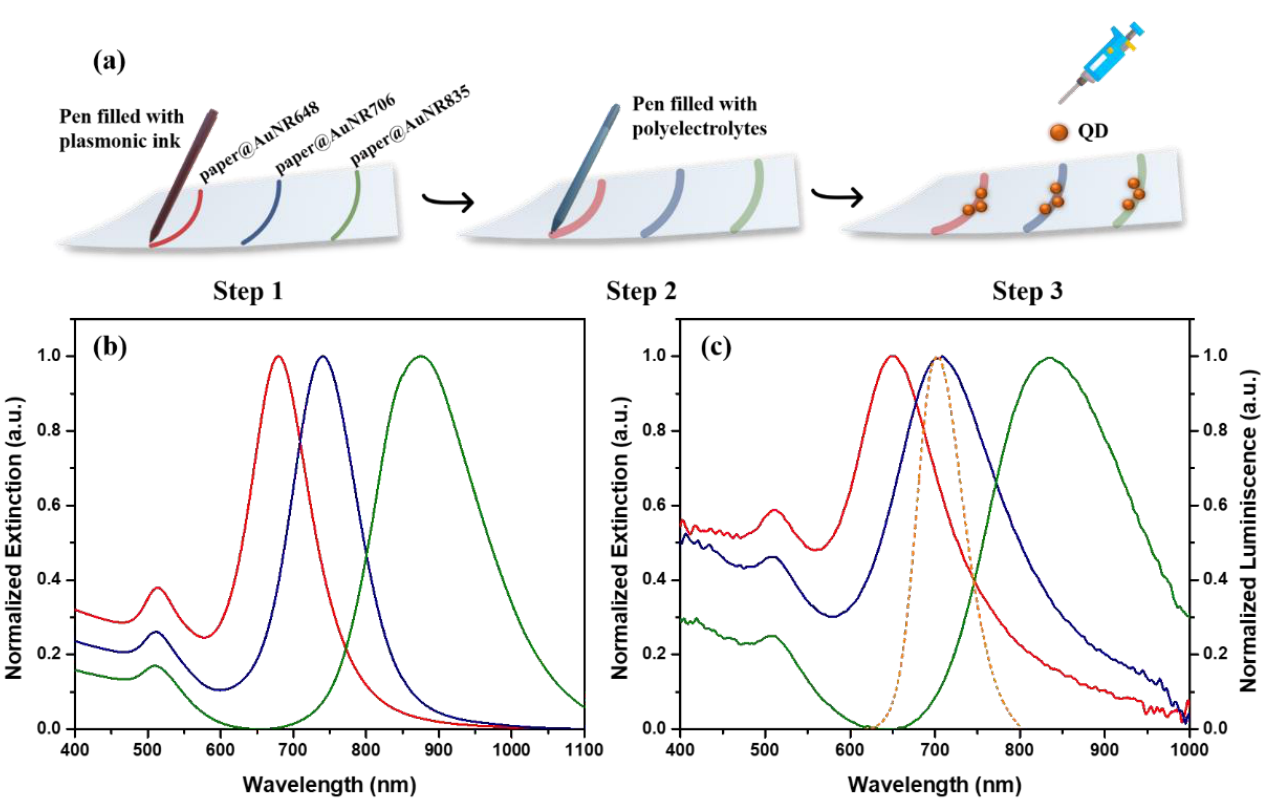
Figure 1. ( a ) Schematic illustration of the plasmonic calligraphy method. Step 1: fabricating the nanoplatform using a commercial pen filled with AuNRs with different aspect ratios as colloidal inks in order to draw spatially isolated plasmonic lines. Step 2: coating the plasmonic arrays with a layer of PSS, followed by a layer of PAH, using the same pen-on-paper approach. Step 3: decorating the nanoplatform with negatively charged QD. ( b ) Normalized extinction spectra of the colloidal AuNRs, with different aspect ratios: AuNR680nm — red spectrum, AuNR740nm — blue spectrum AuNR860nm — green spectrum. ( c ) Calligraphed AuNRs lines on Whatman paper (paper@AuNR648 — red spectrum, paper@AuNR706 — blue spectrum, paper@AuNR835 — green spectrum) together with the normalized luminescence spectrum of QD with the luminescence emission band localized at 700 nm (orange dotted spectrum).